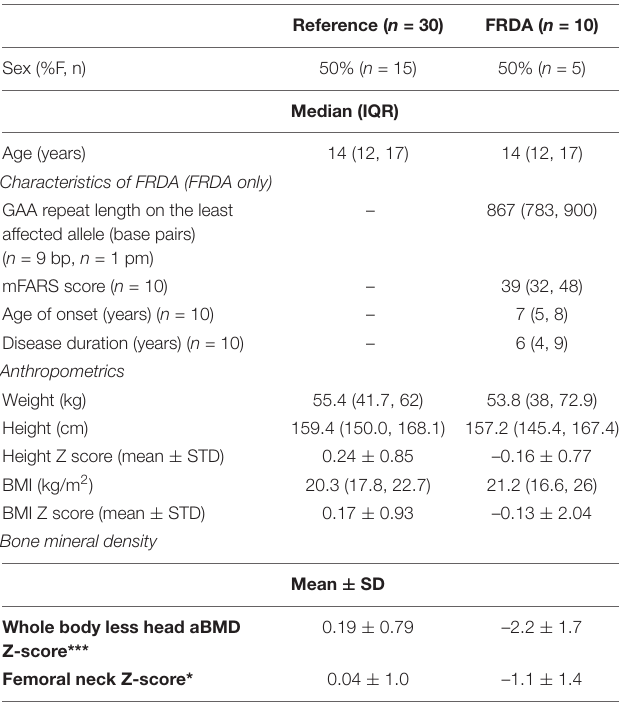
TABLE 2 | Participant characteristics and bone mineral density data for children with and without Friedreich’s Ataxia (FRDA).